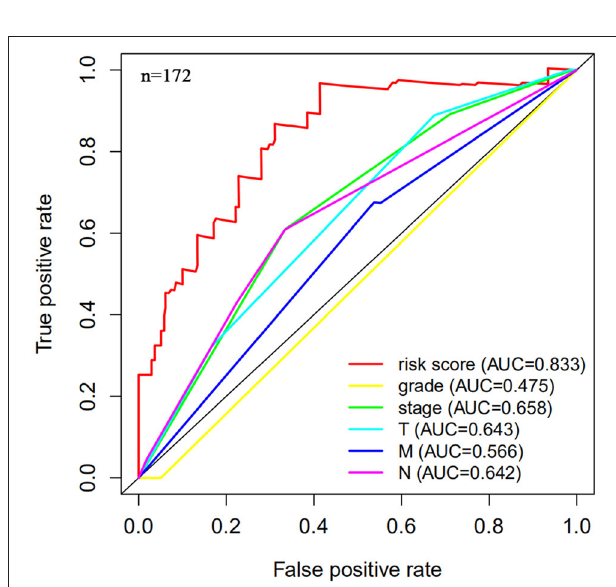
FIGURE 8 | Multi-factor receiver operating curve details. The AUC value of the testing group is significantly more than 0.7, which is greater than the predicted value of clinical